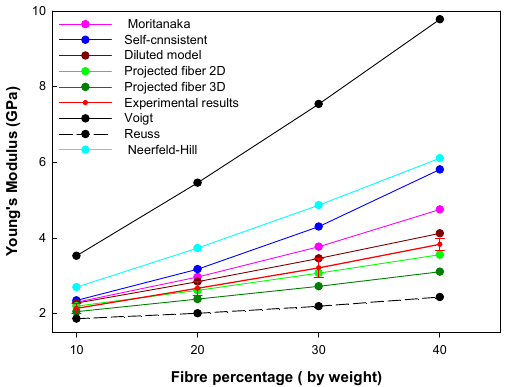
Figure 7. Evolution of the Young’s modulus of the PP/alfa composites according to fiber content for the analytical and numerical homogenization methods.